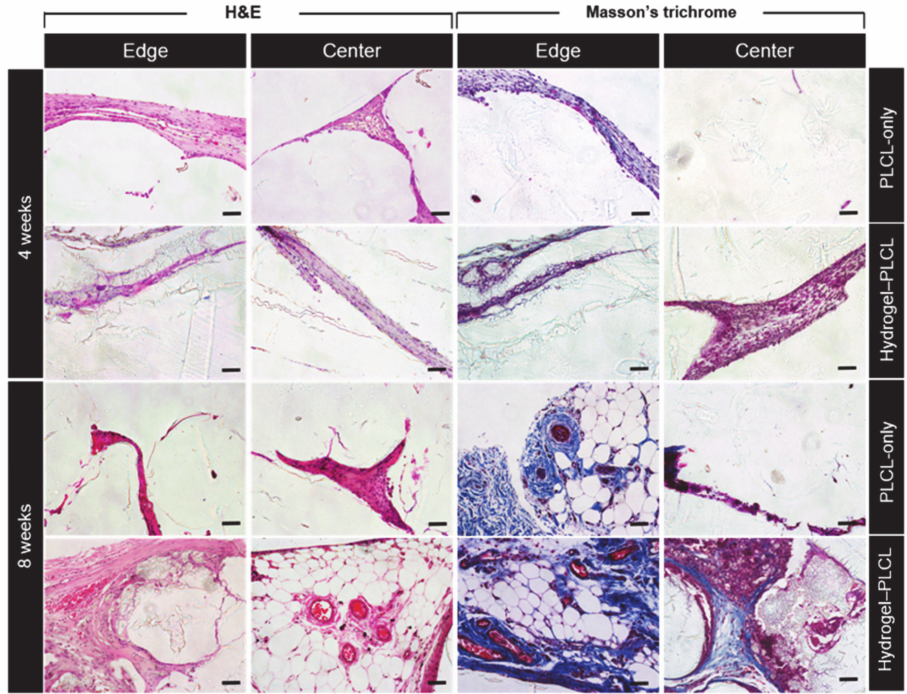
Figure 9. Histological analysis of the scaffolds after specific time points. The specimens were stained with hematoxylin and eosin (H&E) and Masson’s trichrome (MT). Scale bar = 50 µ